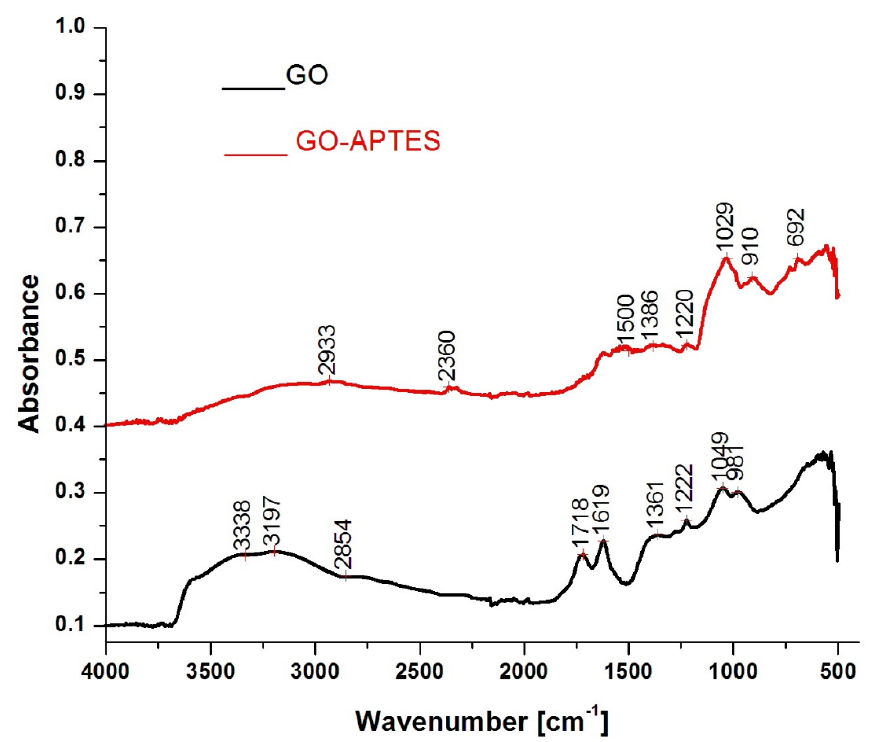
Figure 2. FT-IR spectra of graphene oxide (GO) and silanized graphene oxide (GO-APTES).